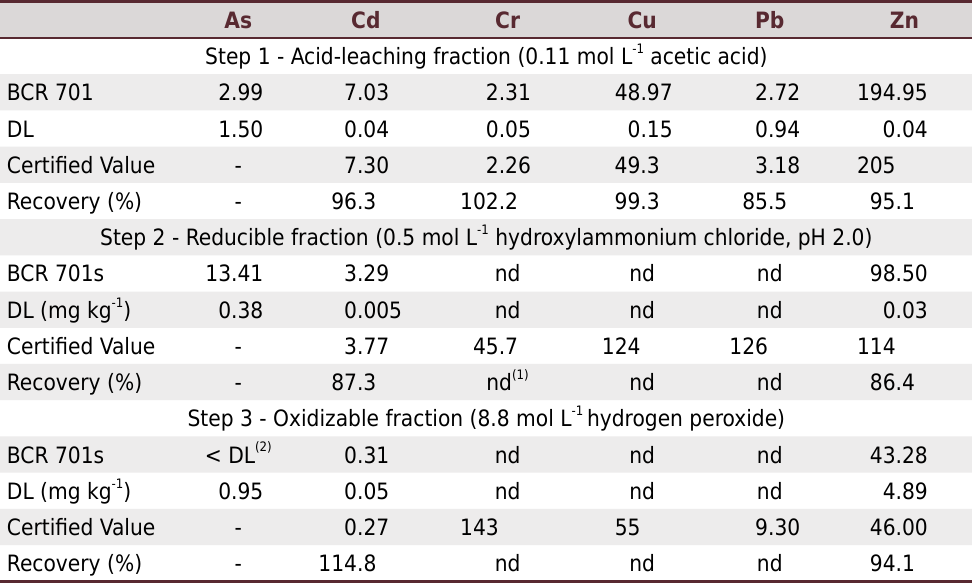
Table 2. Quality control for BCR sequential analysis As